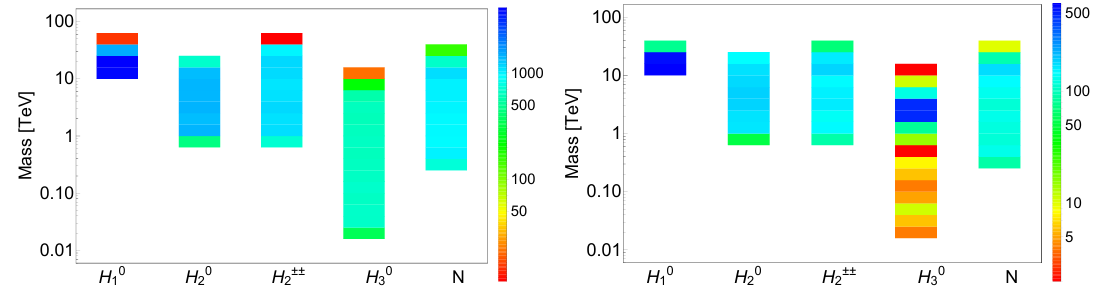
, H 0 , H ±± , H 0 and N , 3 1 2 2